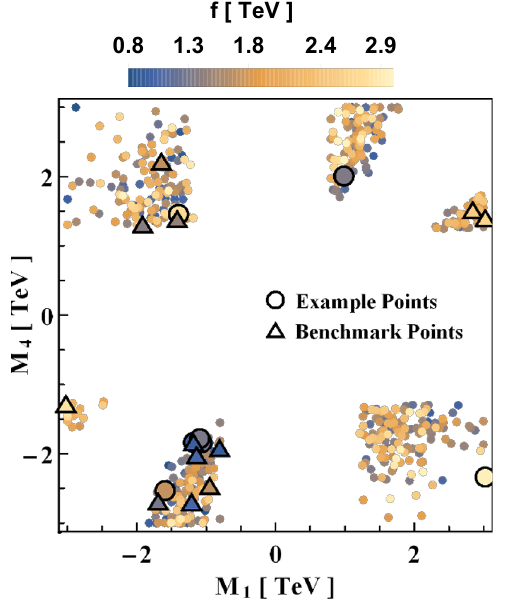
Figure 14 . Low scale scan of the MCHM 14 parameter space, including example points of table 2, benchmark points of table 6 and the points consistent with constraints in eqs. 4.1 and 4.2.